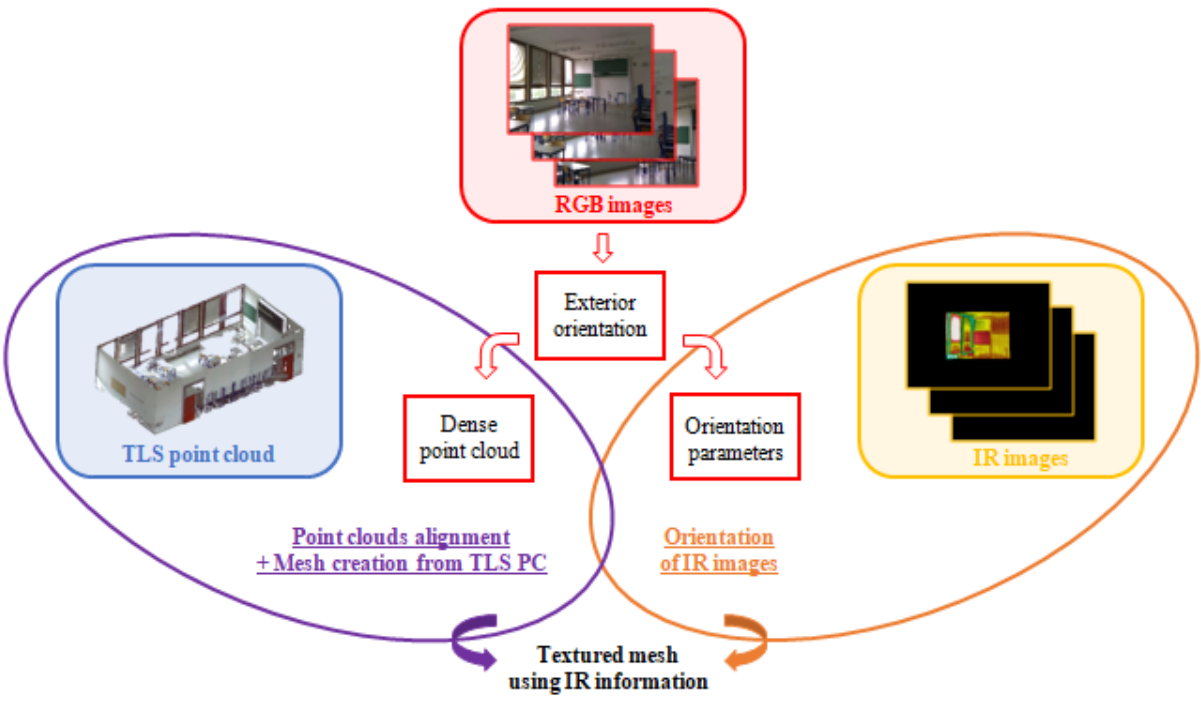
Figure 4. Overview of the processing